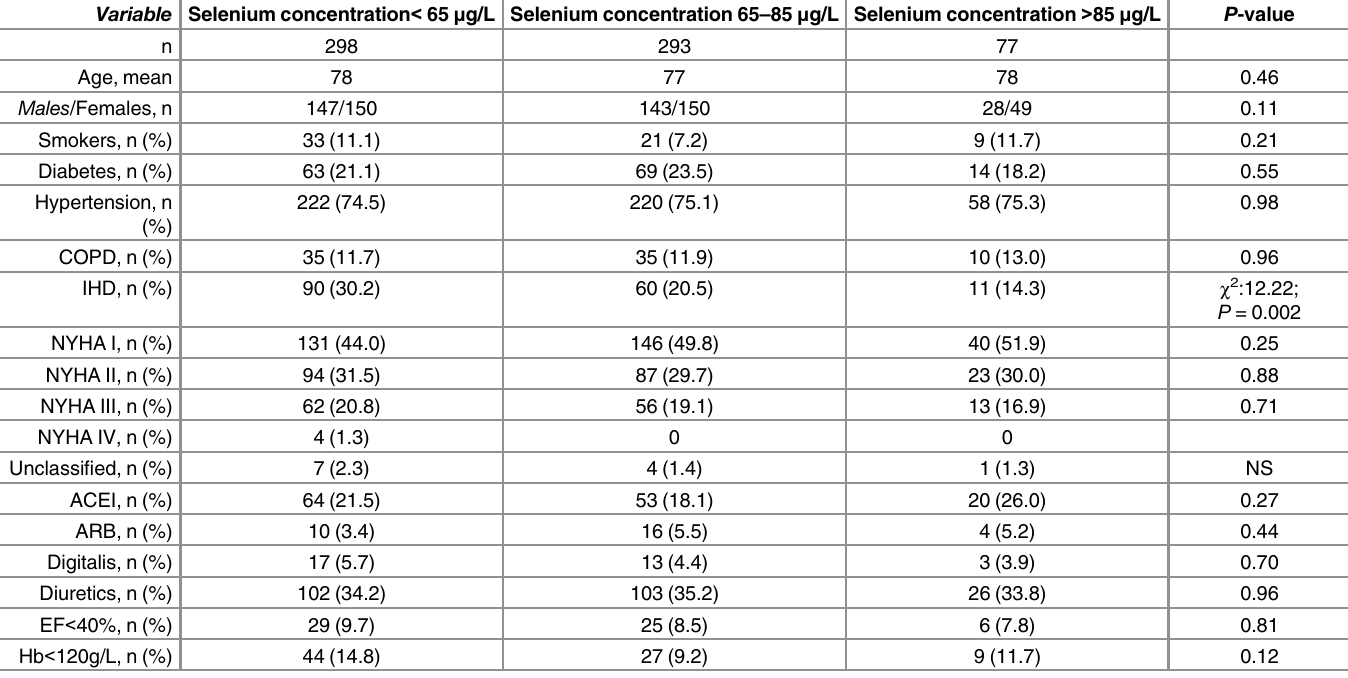
Table 1. Baseline characteristics of the study population divided into a serum selenium concentration of < 65 μ g/L, 65 – 85 μ g/L or a selenium con- centration > 85 μ